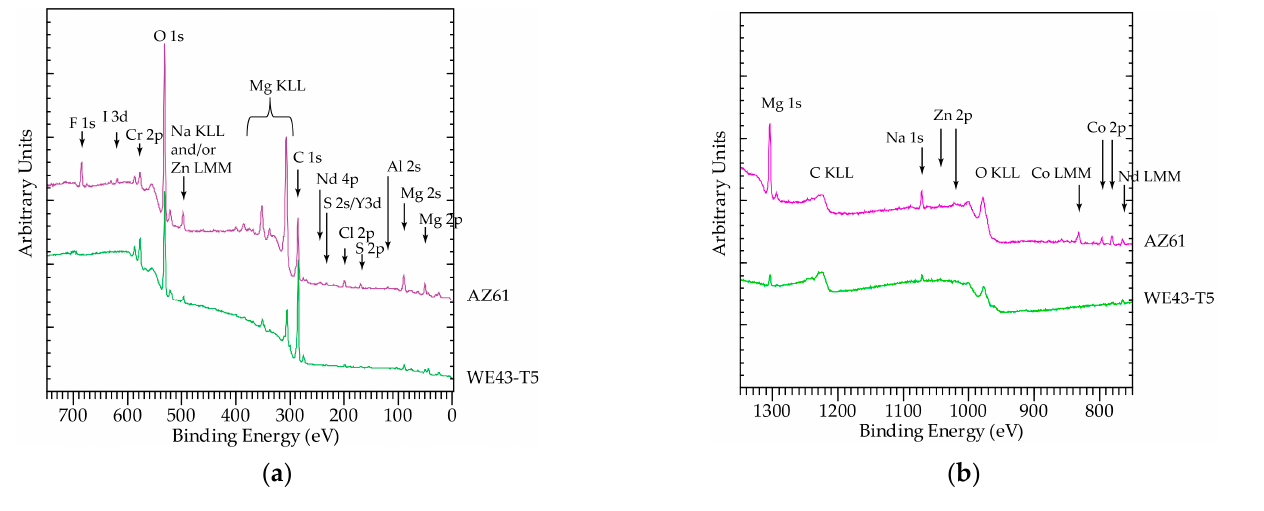
Figure 12. Survey spectra of samples analyzed: ( a ) 0-700 (eV) and ( b ) 800-1300 (eV).